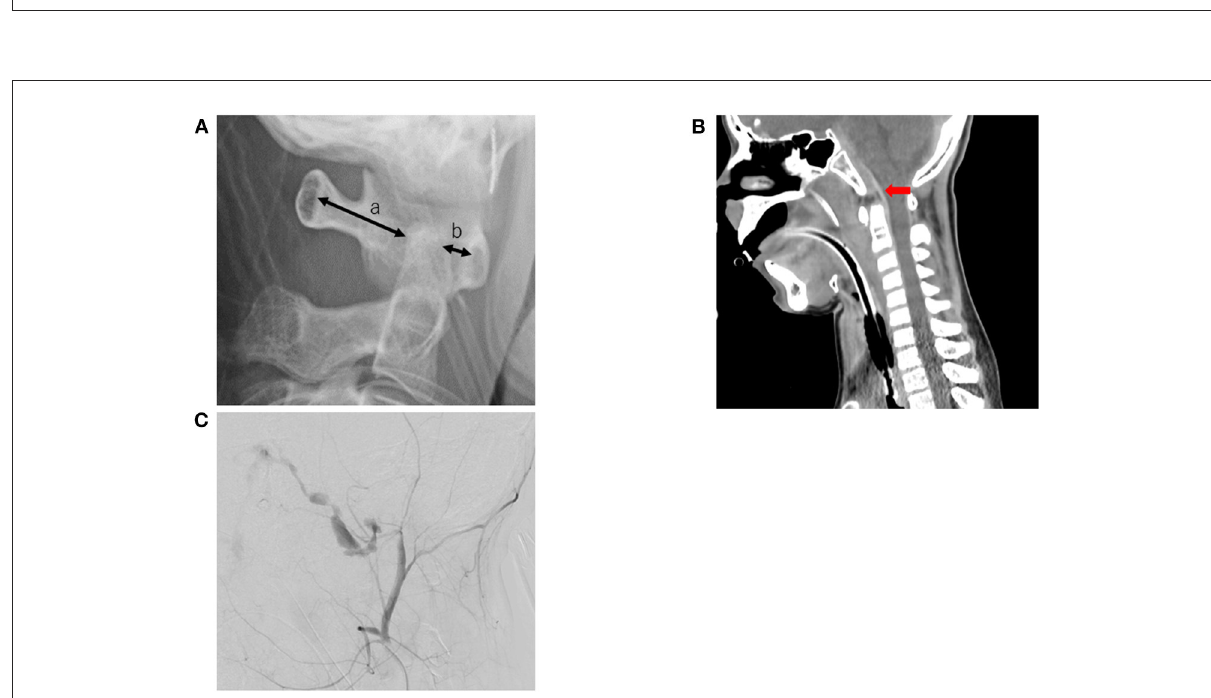
FIGURE2 Clinical course. (A) The patient’s tongue was completely immobile and he was unable to move it from side to side 3 days after the accident. (B) The patient’s tongue could be moved but was slightly atrophied. (C) The patient’s tongue could move in full range, and the atrophy